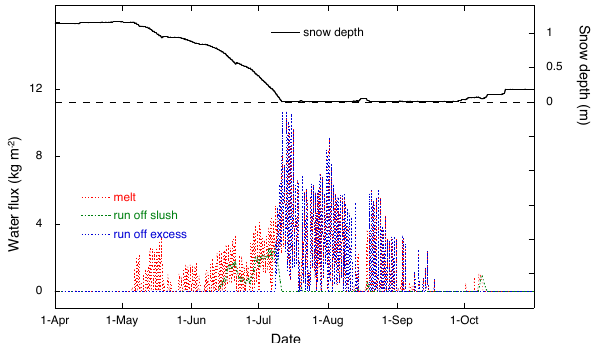
Fig. 9. Time-series of the snow depth, melt and runoff at S6 in the ablation zone for the year